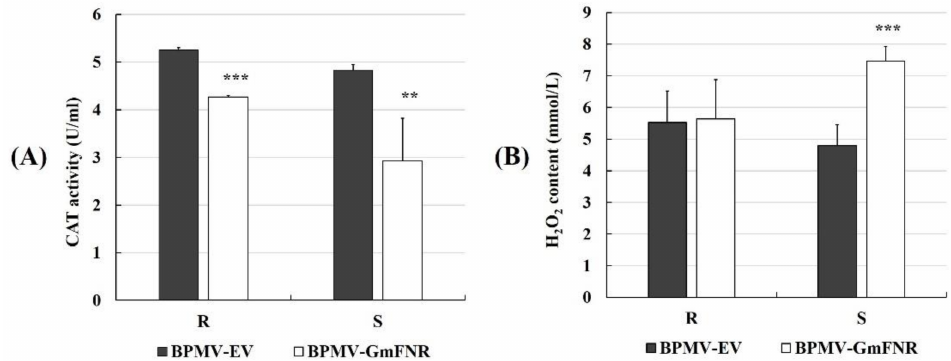
Figure 4. The CAT activity ( A ) and H 2 O 2 content ( B ) of control (BPMV-EV) and silencing (BPMV-GmFNR) plants of resistant (R) and susceptible (S) lines at 10 days post inoculation (dpi). “**” and “***” indicate the statistical significance at p < 0.01 and p < 0.001, t -test.